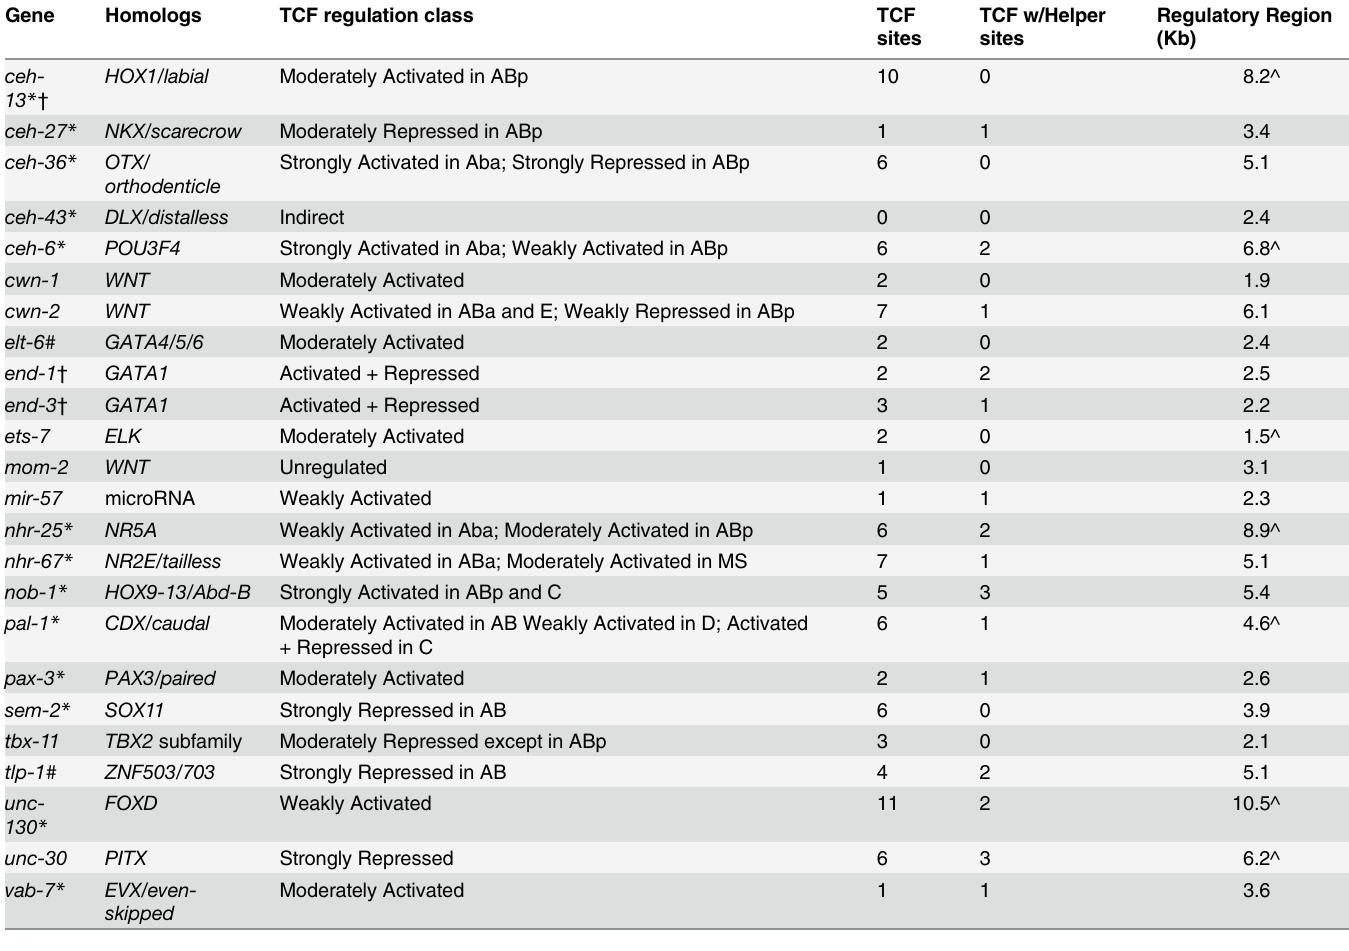
Table 1. Posterior lineage-dependent genes are targets of